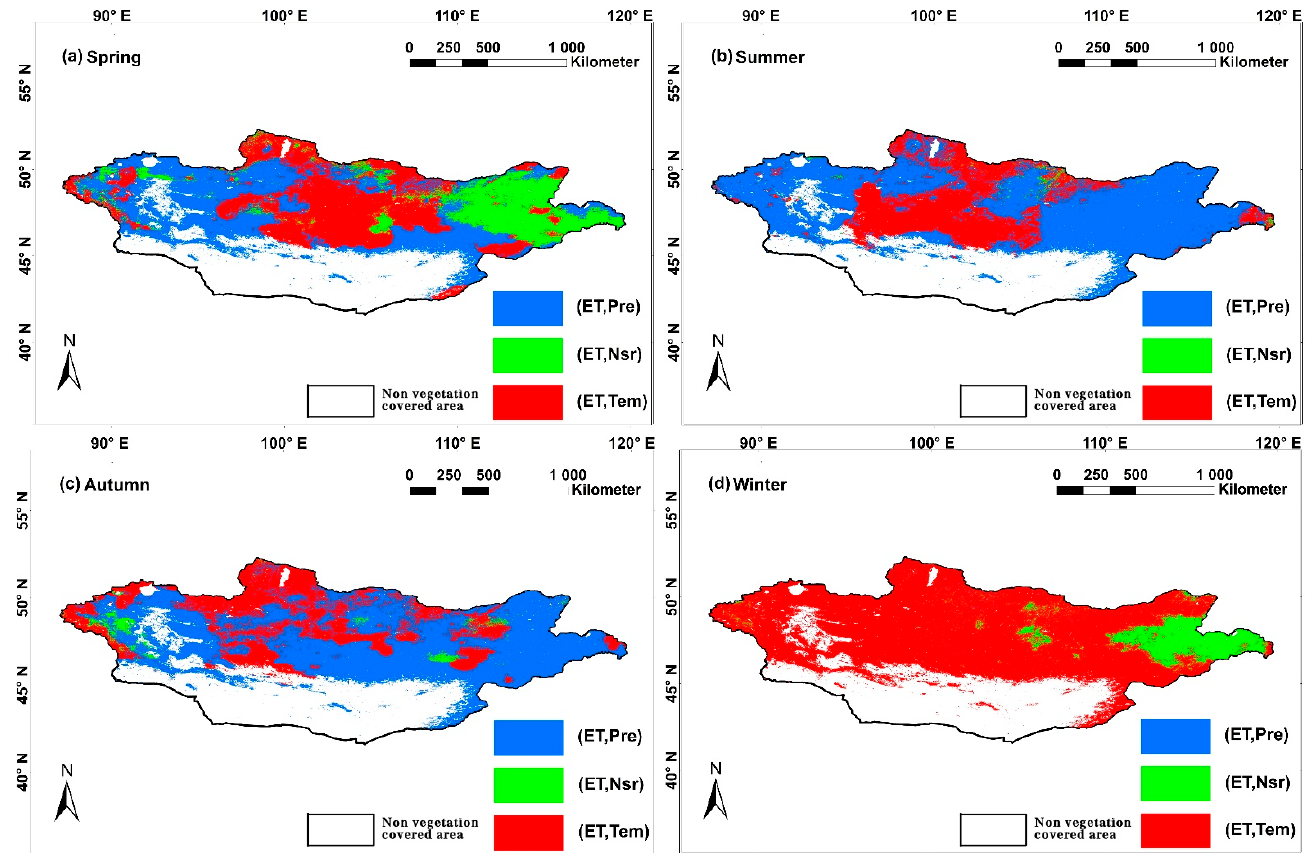
Figure 6. Spatial distributions of the positive correlations of the main meteorological driving factors of ET in all four seasons in Mongolia from 2001 to 2020: ( a ) spring, ( b ) summer, ( c ) autumn, and ( d ) winter.